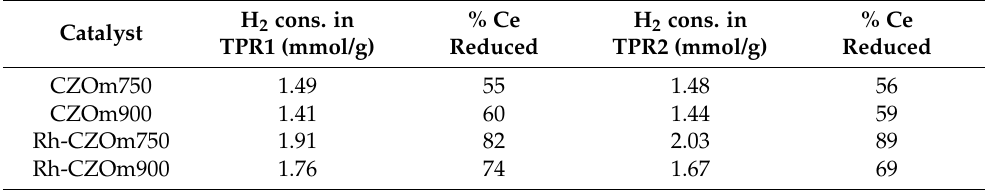
Table 3. Hydrogen consumption during temperature-programmed reduction for bare supports and impregnated